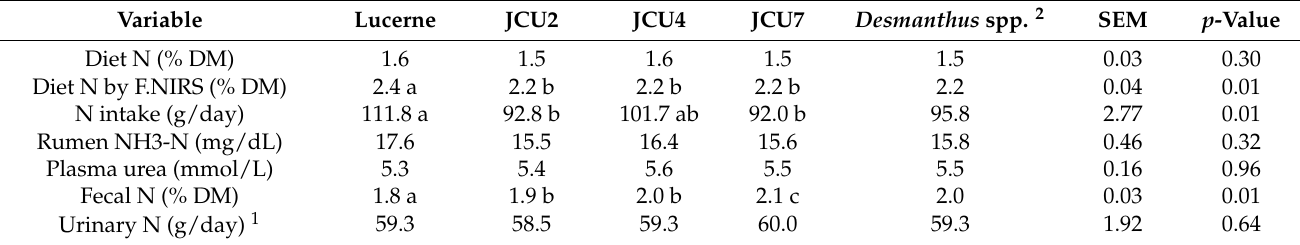
Table 6. Dietary, plasma, rumen, fecal, and urinary N metabolism in steers supplemented with lucerne and Desmanthus spp. Variable